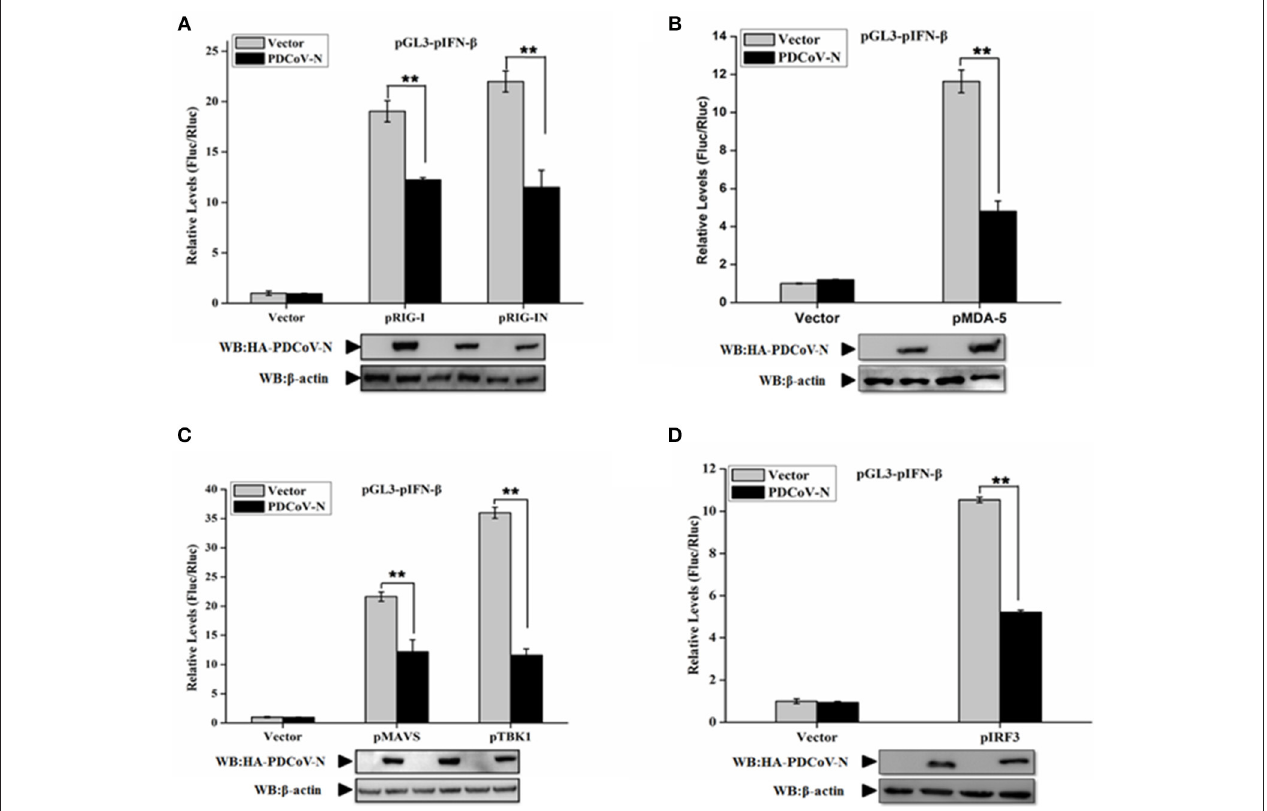
FIGURE 2 | PDCoV N protein inhibited porcine IFN- β promoter activation by the porcine RLR signaling pathway. PK-15 cells were cotransfected with pGL3-pIFN- β ,pRL-TL, and pcDNA3.1-HA-PDCoV-N along with constructed expression porcine RIG-I/RIG-IN (pRIG-I/pRIG-IN) (A) , porcine MDA5 (pMDA5) (B) , porcine MAVS (pMAVS) (C) , porcine TBK1 (pTBK1) (C), or porcine IRF3 (pIRF3) (D) . Dual-luciferase assays were performed at 24h post transfection. The relative firefly luciferase activity was relative to that of an empty vector control. The Renilla reniformis luciferase activity was used to normalize. Western blot was used to